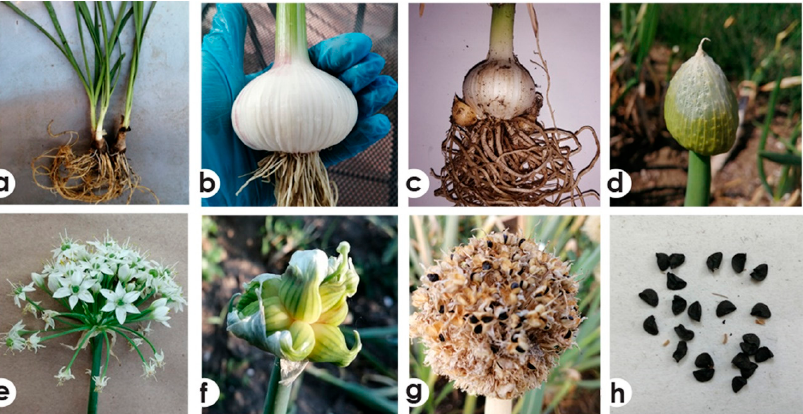
Figure 3. Morphological parts of Allium plants: ( a ) rhizomes; ( b ) tunicate bulb; ( c ) li tt le bulbs, as propagating material; ( d ) spathe; ( e ) fl owers in the in fl orescence; ( f ) bulbils in the in fl orescence; ( g ) fruits (capsules); ( h ) seeds (photos by S. Vukovi ć